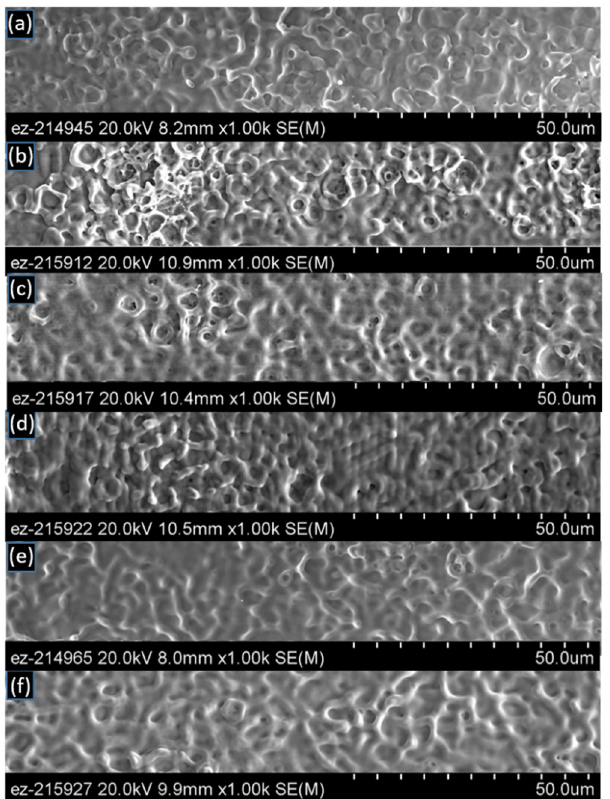
Figure 7. SEM micrographs (2000×) of the laser-interference-processed area using the spot-by-spot method with a 5 mm spot size on copper. Each frame shows a different number of pulses per spot: Table 3. Topology variation for spot-by-spot laser-interference processing with 5 mm spot size. Case No. N P